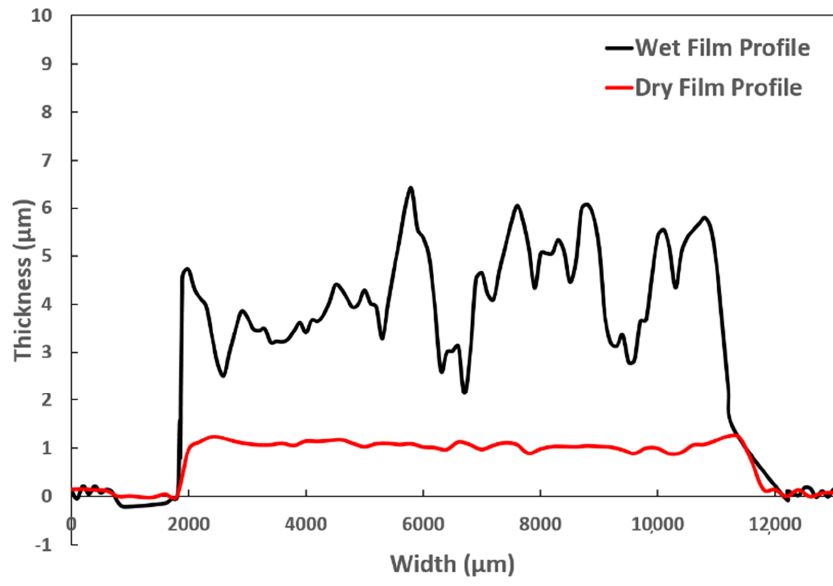
Figure 4. Optical profile for wet film and dry film for a single